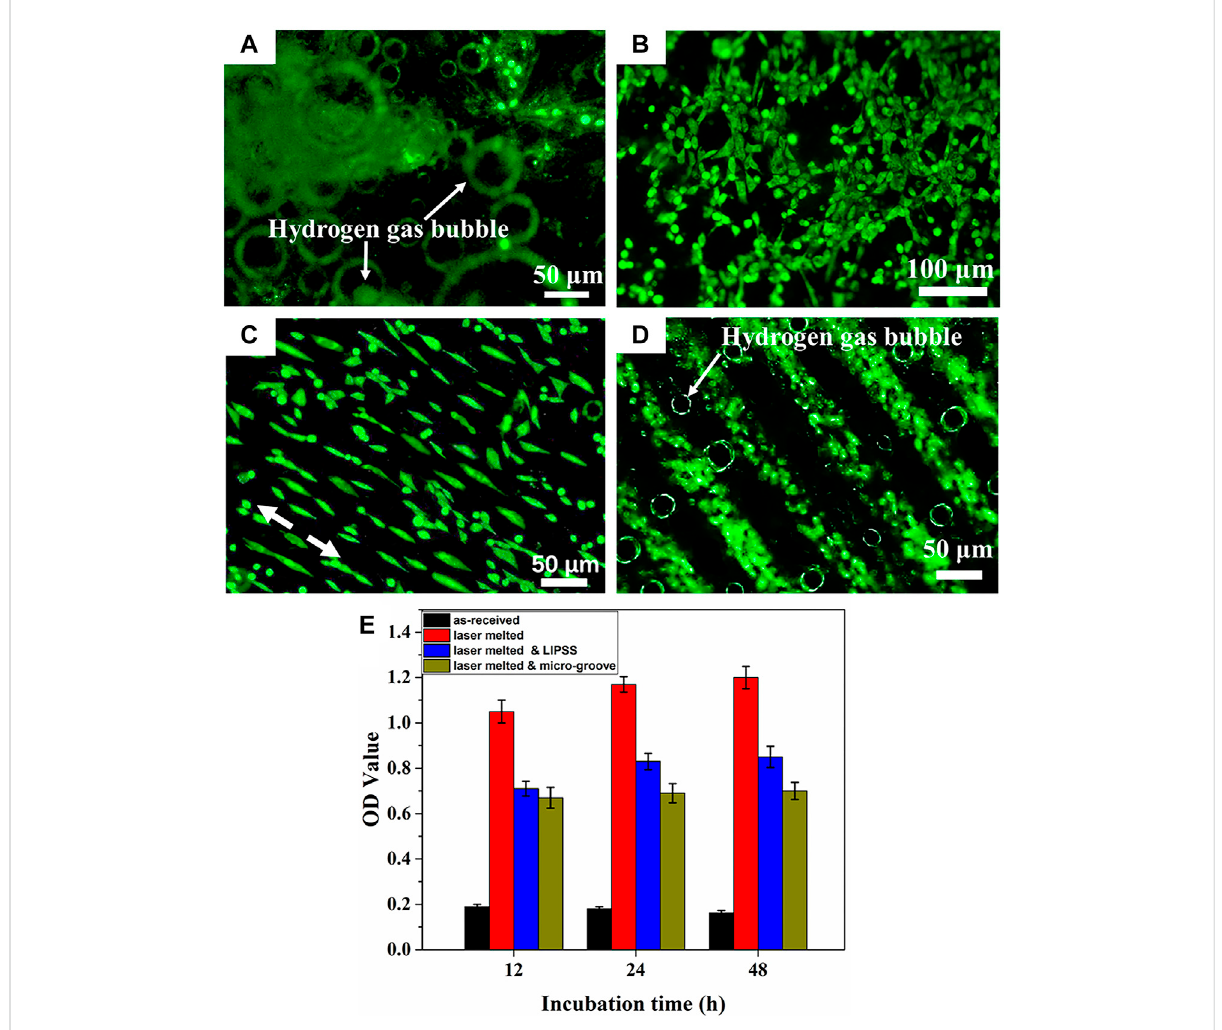
FIGURE 11 Fluorescence images of the MC3T3-E1 cell on (A) as-received, (B) laser melted, (C) laser melted and LIPSS, (D) laser melted and micro-groove surface and (E) cell proliferation after cultured for 48 h. Reprinted with permission from reference (Zhang et al., 2019),